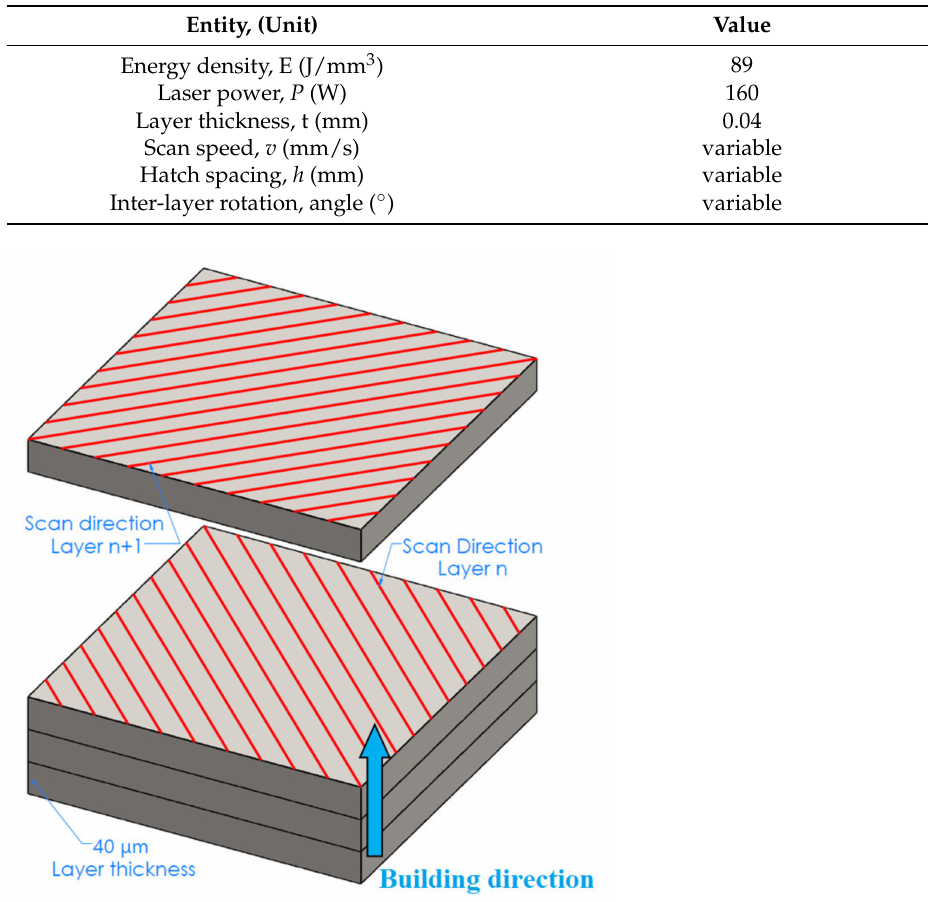
Table 2. Process parameters adopted for the L-PBF prints.